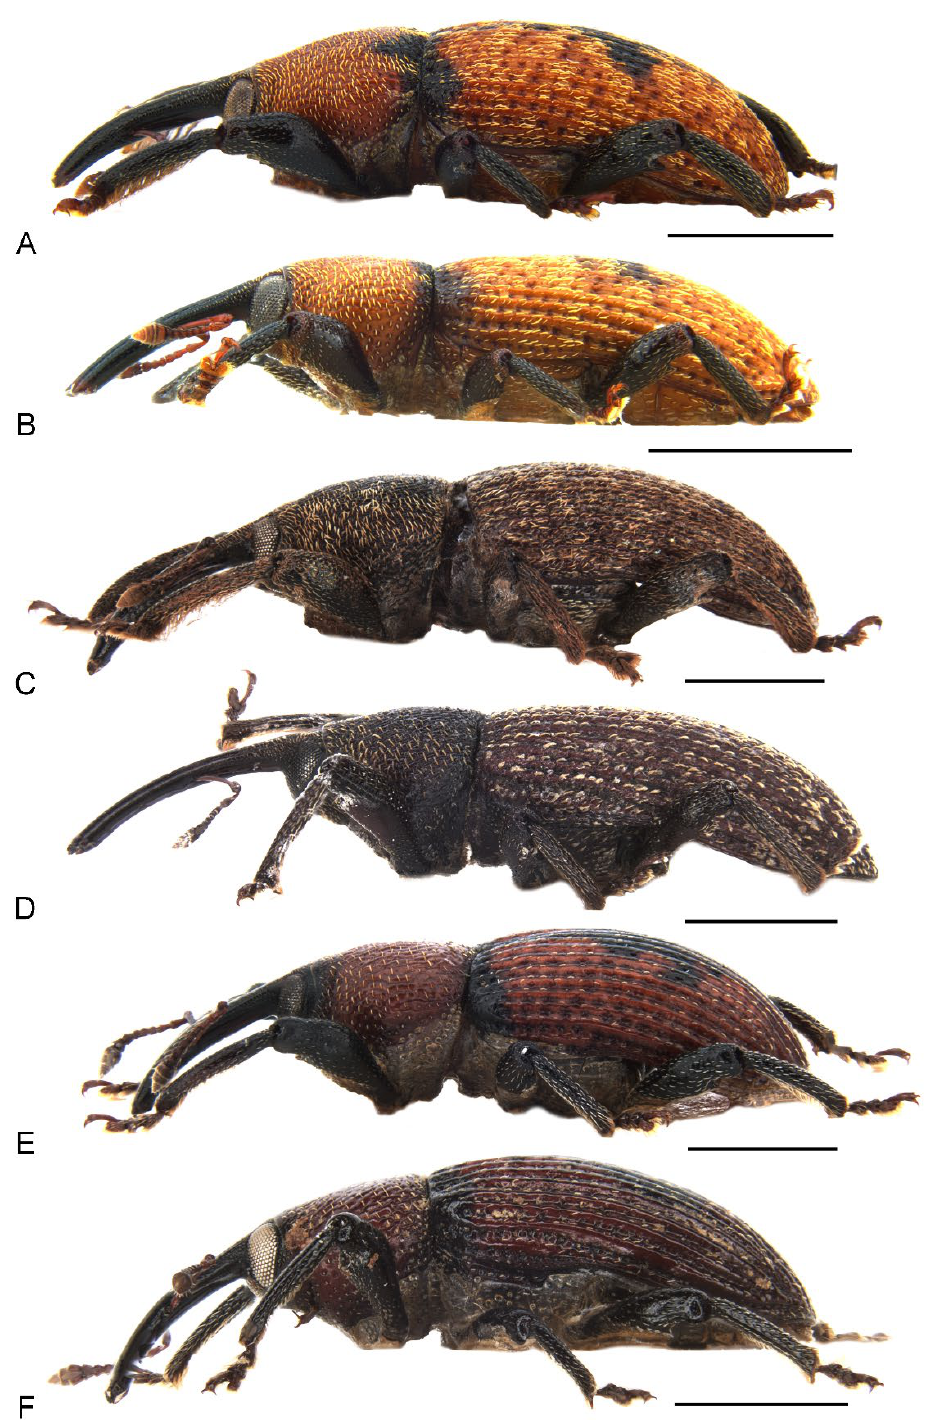
Figure 2. Habitus of Miltotranes adults, lateral view: ( A ) M. prosternalis , male; ( B ) ditto, female; ( C ) M. subopacus , male; ( D ) ditto, female; ( E ) M. wilsoni sp. n., holotype; ( F ) ditto, female, paratype. Scale bars: 2.0 mm.